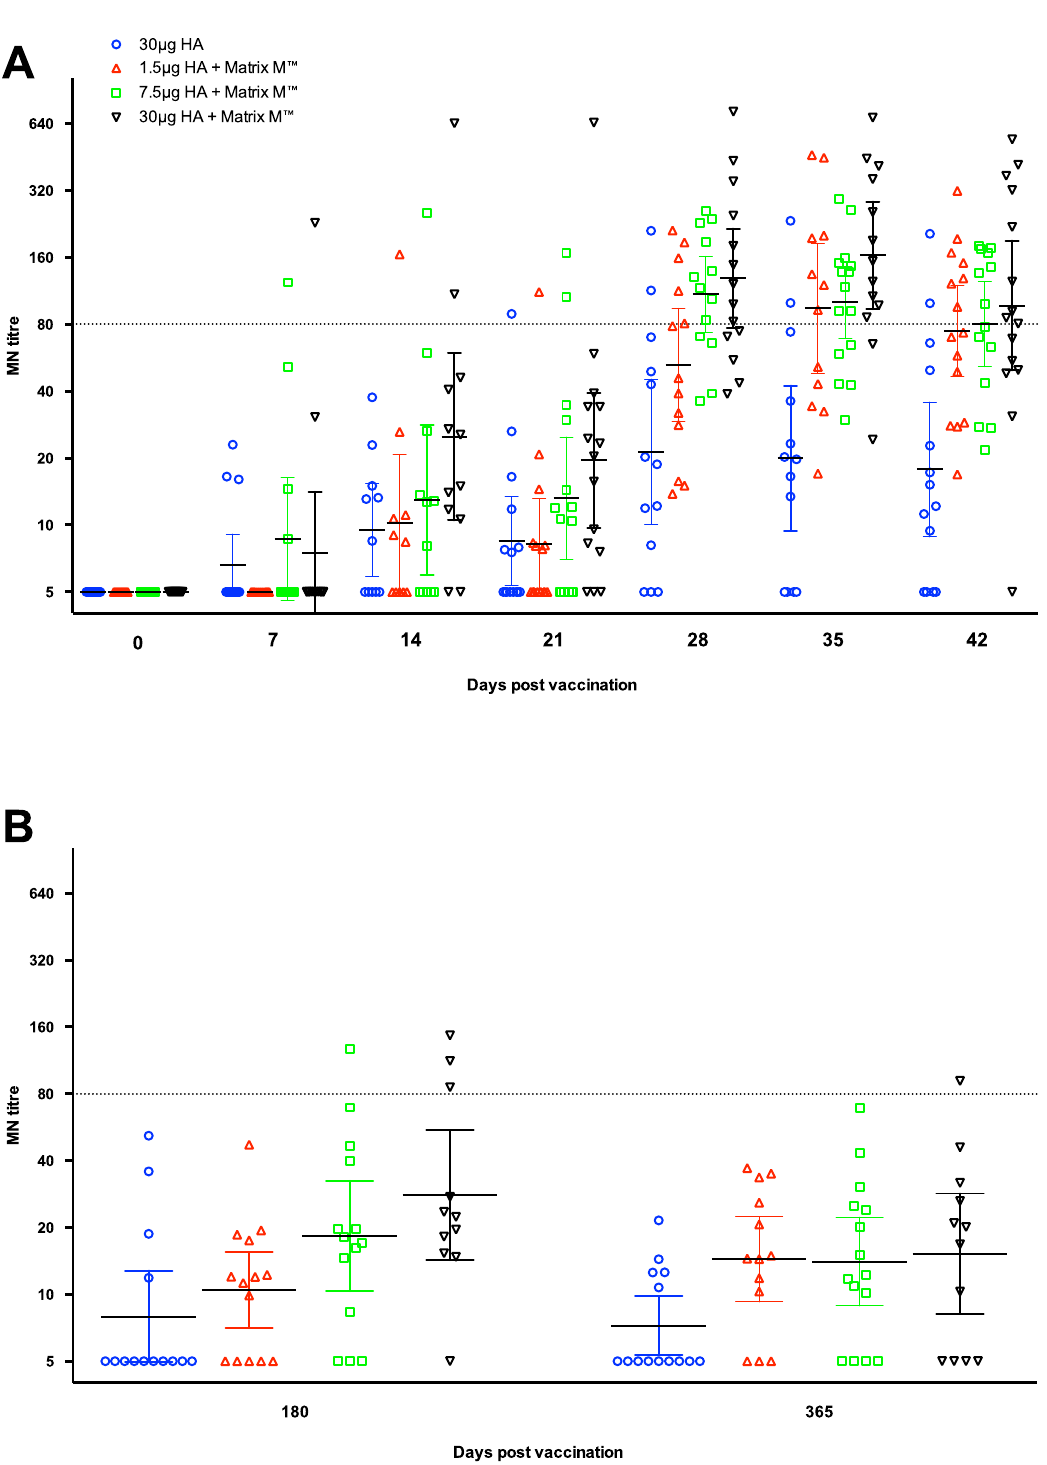
Fig 2. The kinetics and long-term microneutralization response after vaccination. The kinetics (A) and long-term (B) microneutralization (MN) antibody response to the homologous vaccine strain A/Vietnam/1194/2004 (NIBRG-14) after vaccination with two doses (21 ± 1 days apart) of inactivated virosomal H5N1 vaccine alone (30 μ g HA, blue) or 1.5 (red), 7.5 (green) or 30 μ g HA (black) adjuvanted with Matrix-M (50 μ g). The sampling day after vaccination is shown on the x-axis. Each symbol represents the geometric mean MN titre for one individual participant, with the group geometric mean titre and 95% confidence interval presented. The dotted line indicates the protective MN titre of